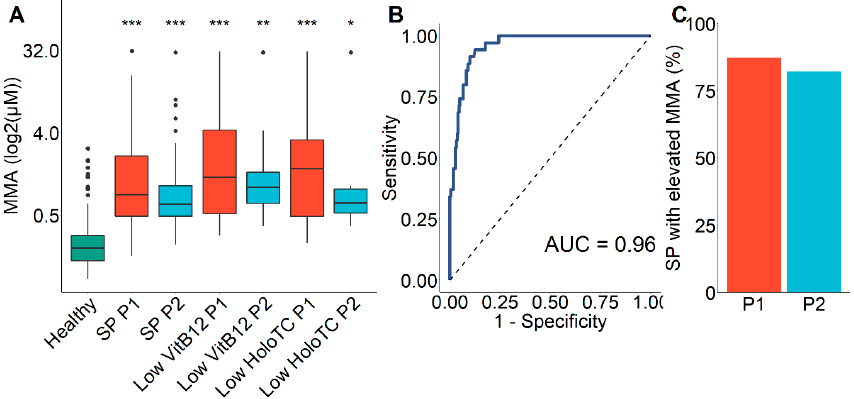
Figure 4. Evaluation of screening-positives by determination of, methylmalonic acid (MMA) from dried blood spots. ( A ) Markedly increased MMA concentrations in screening-positive samples. Boxplots for MMA serum concentrations of healthy newborn population (N = 242), screening- positives (N = 77 and N = 54 for period 1 and 2, respectively), screening-positives with known low serum vitamin B12 (VitB12) (N = 42 and N = 17 for period 1 and 2, respectively) and screening- positives with known low holotranscobalamin (holoTC) (N = 31 and N = 12 for period 1 and 2, respectively) concentrations are shown. *, p < 0.05; **, p < 0.01; ***, p < 0.001 vs. healthy, other comparisons were non-significant. ( B ) Receiver operating characteristic (ROC) curve analysis. Separation of newborns with normal and low VitB12 concentrations by MMA (cutoff: 0.423 µM). ( C ) Proportion of screening-positive samples with increased MMA concentrations. Red bars show values for the first screening period, blue bars for period 2 and green bars for healthy newborns; P1, first period; P2, second period of screening; SP, screening positive; AUC, area under the curve. Interestingly, the selection for tHCy analysis in the second period tended towards lower positive predictive values for low VitB12 and HoloTC and high MMA concentrations (Figures 3B,D and 4C) compared to the first period. To gain information on the underlying cause, we analyzed the data with